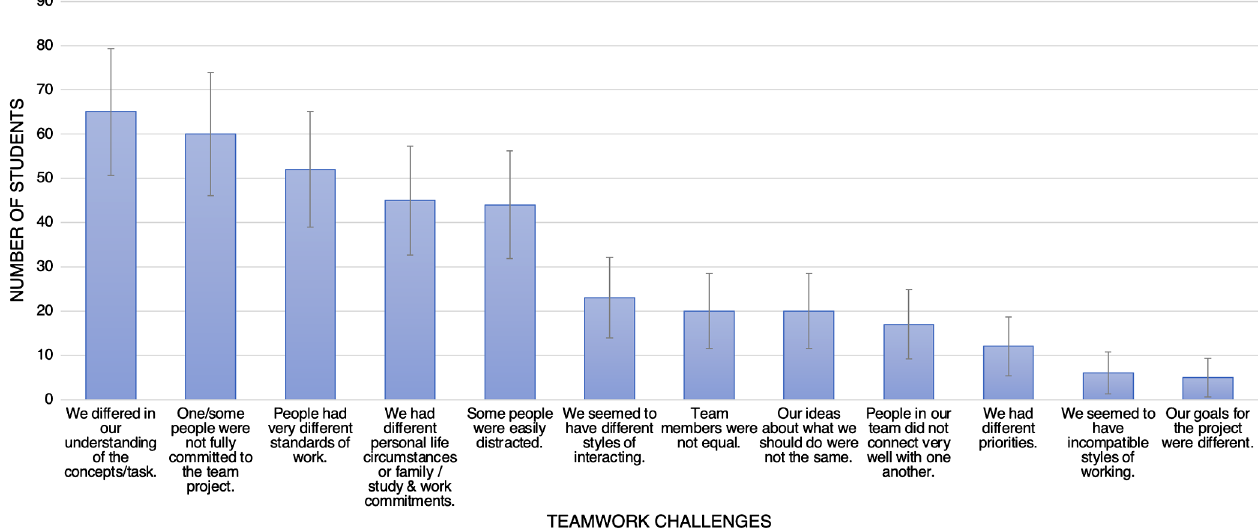
FIG. 4. Biggest challenges as reported by students. Students were asked to choose their “ biggest ” challenge from the list of goals shown on the x axis. Uncertainties are calculated using the binomial confidence interval with alpha ¼ 95%